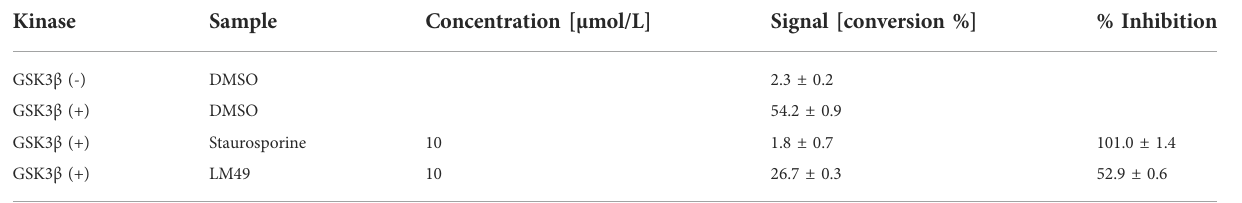
TABLE 1 GSK3 β kinase activity measured by Off-chip Mobility Shift Assay.